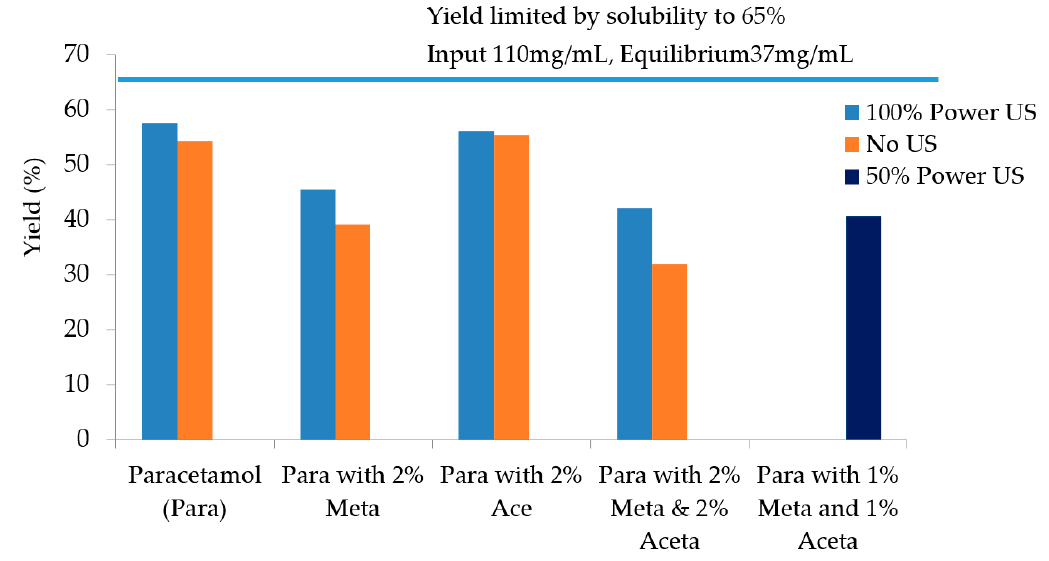
Figure 5. Yield of crystallisation with and without ultrasound in comparison with the yield limited by solubility to 65%, showing yield for the crystallisation process that approaches the equilibrium yield more closely with the use of ultrasound and that the presence of impurities impedes the desupersaturation process.